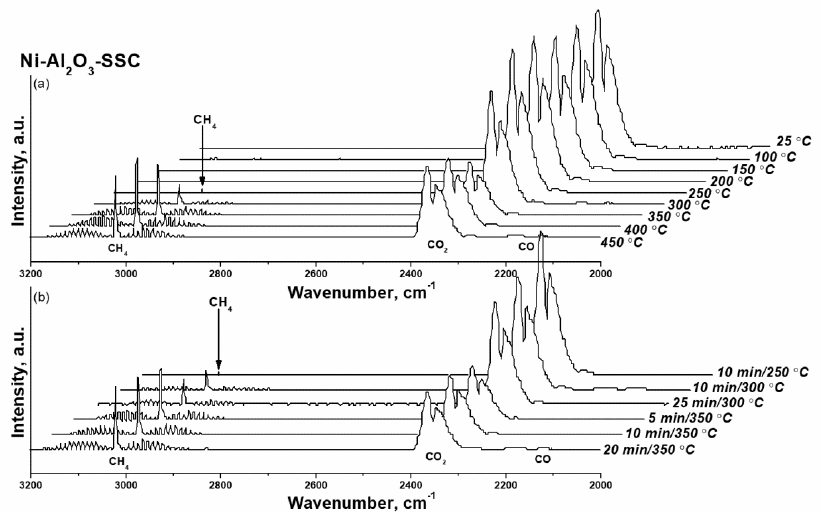
Figure 12. FTIR spectra of the gas at the outlet of the reactor when the Ni-Al 2 O 3 -SSC catalyst was activated at varying ( a ) the temperature and ( b ) duration of the process. Activation conditions: volume ratio is H 2 :CO 2 :Ar = 16:4:80, and flow rate is 19,000 cm 3 ·g cat − 1 ·h − 1 .